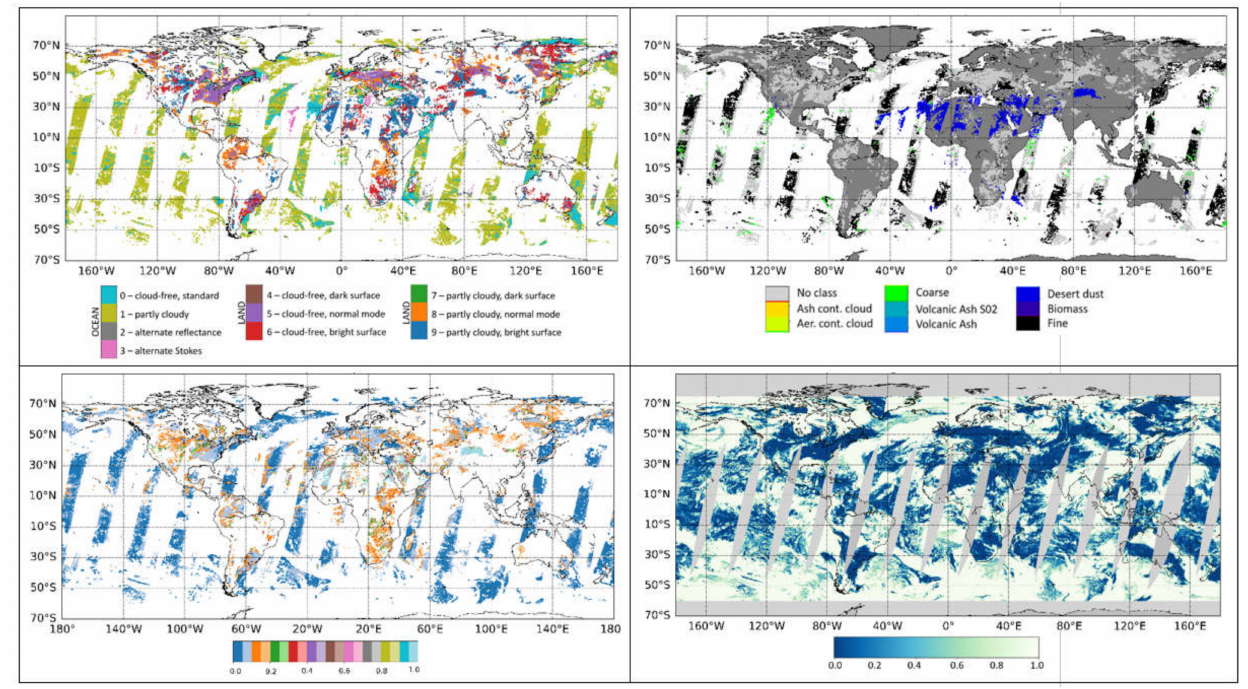
Figure 5. Parameters associated with the AOD in the PMAp aerosol product. Retrieval approach (top-left), aerosol class (top-right), AOD uncertainty (bottom-left), and cloud fraction (bottom-right) associated with the AOD illustrated in Figure